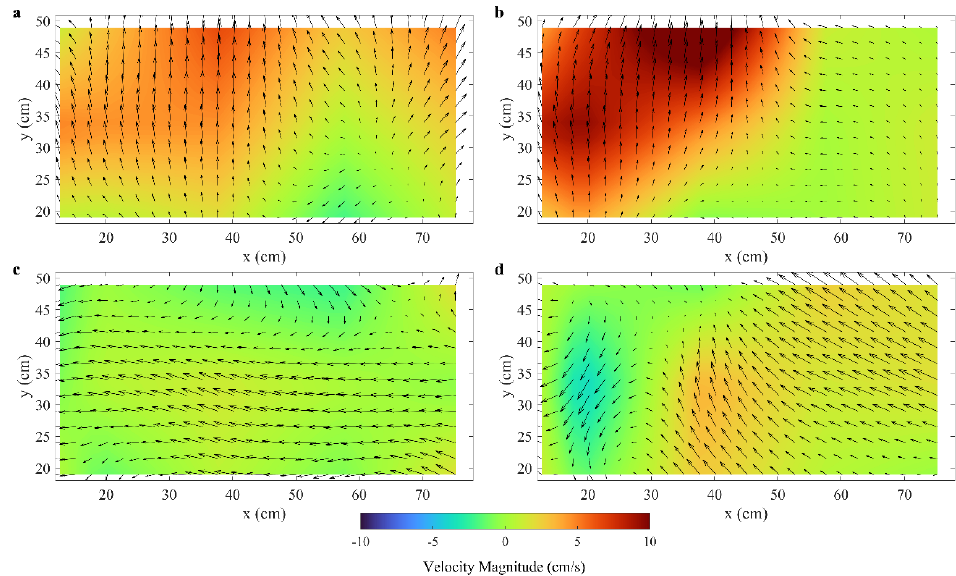
Figure 4. Velocity magnitude contour with velocity vectors measured in front of the ASFL without attraction flow at a depth of ( a ) 30 cm and ( c ) 80 cm and with attraction flow at a depth of ( b ) 30 cm and ( d ) 80 cm. The y–axis origin is the entrance of the ASFL, centered at x = 45 cm. Attraction flow nozzles are located at y = 0, x = 20 and 70 cm. Note, the orientation is the same as Figure